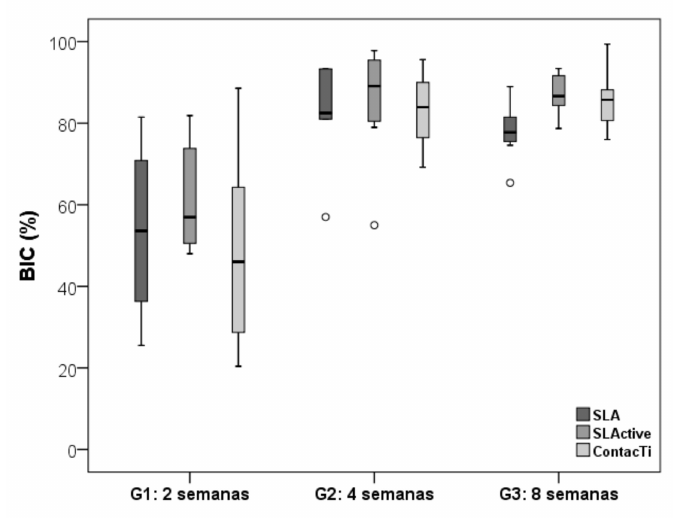
Figure 4. Mean values of the bone-implant contact, BIC (%), for the three surfaces at the di ff erent time points in the study. With the box diagram are determined the outliers (circle) that go out of the standard (extreme